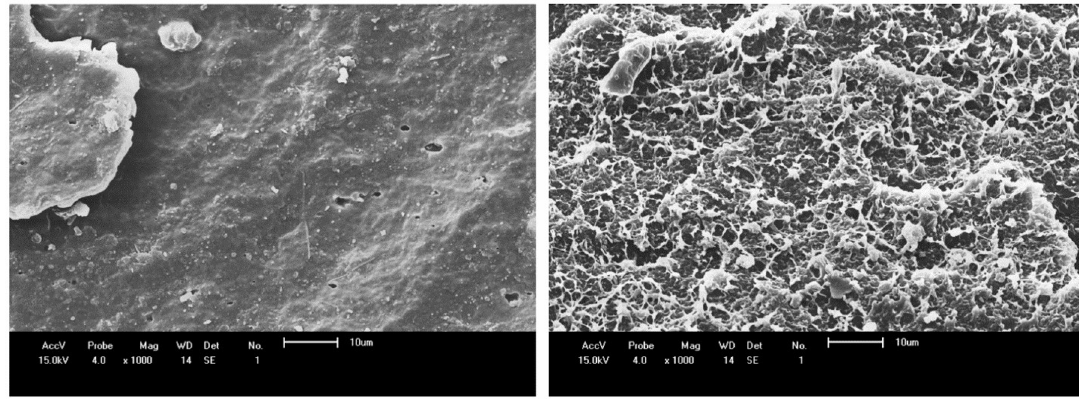
Figure 10. SEM images of fractured surfaces of PHB/1%AP before (left) and after (right) thermal aging at 115ºC for 120 hours. Magnification of